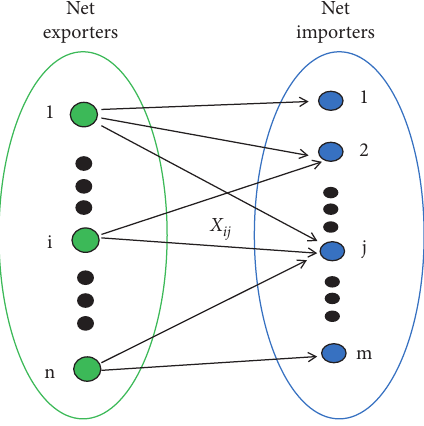
Figure 1: An example of crude oil trade bipartite network